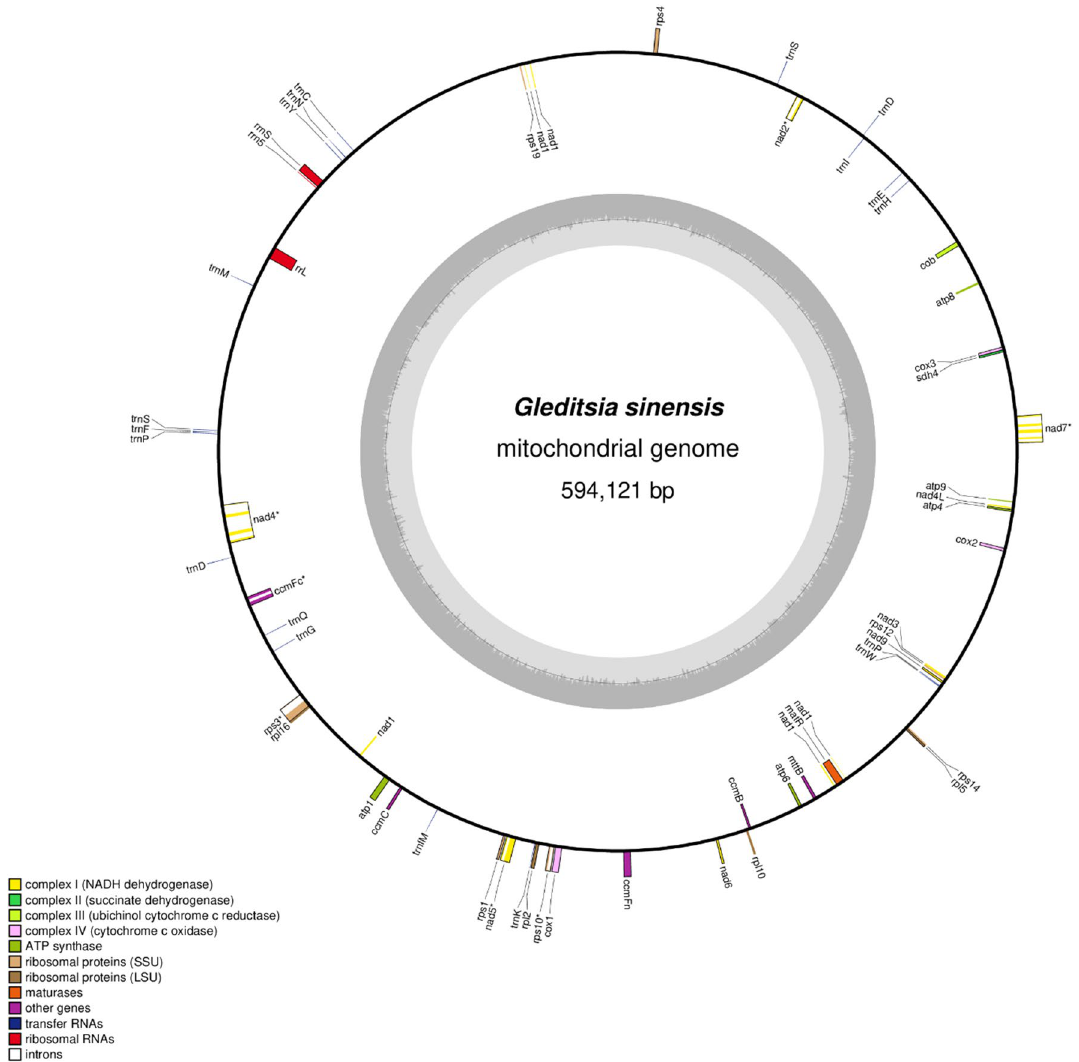
Figure 1. Genome map of the G. sinensis mt genome. Genes belonging to the functional group are color-coded on the circle as transcribed clockwise (outside) and transcribed counter-clockwise (inside). The darker gray in the inner circle represents the GC content, while the lighter gray represents the AT